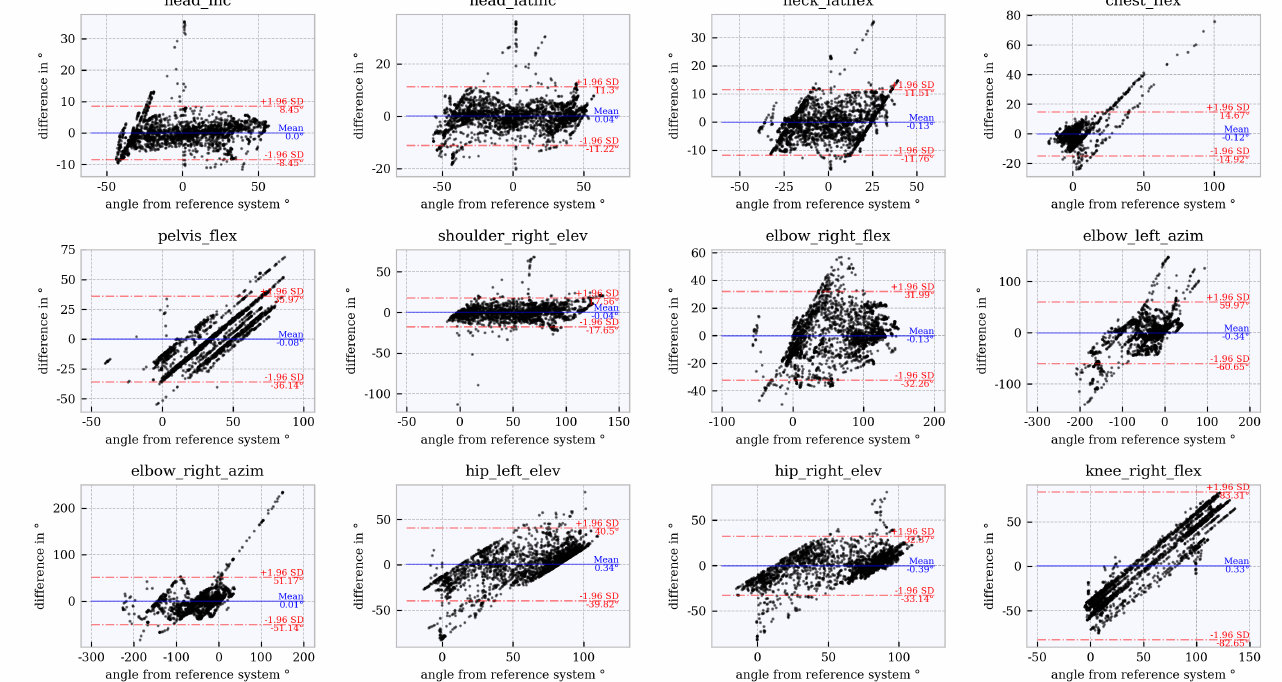
Figure A1. Bland–Altman plot for tracker configuration 3 ; x does not show the average of both systems but the joint angles of the reference system,